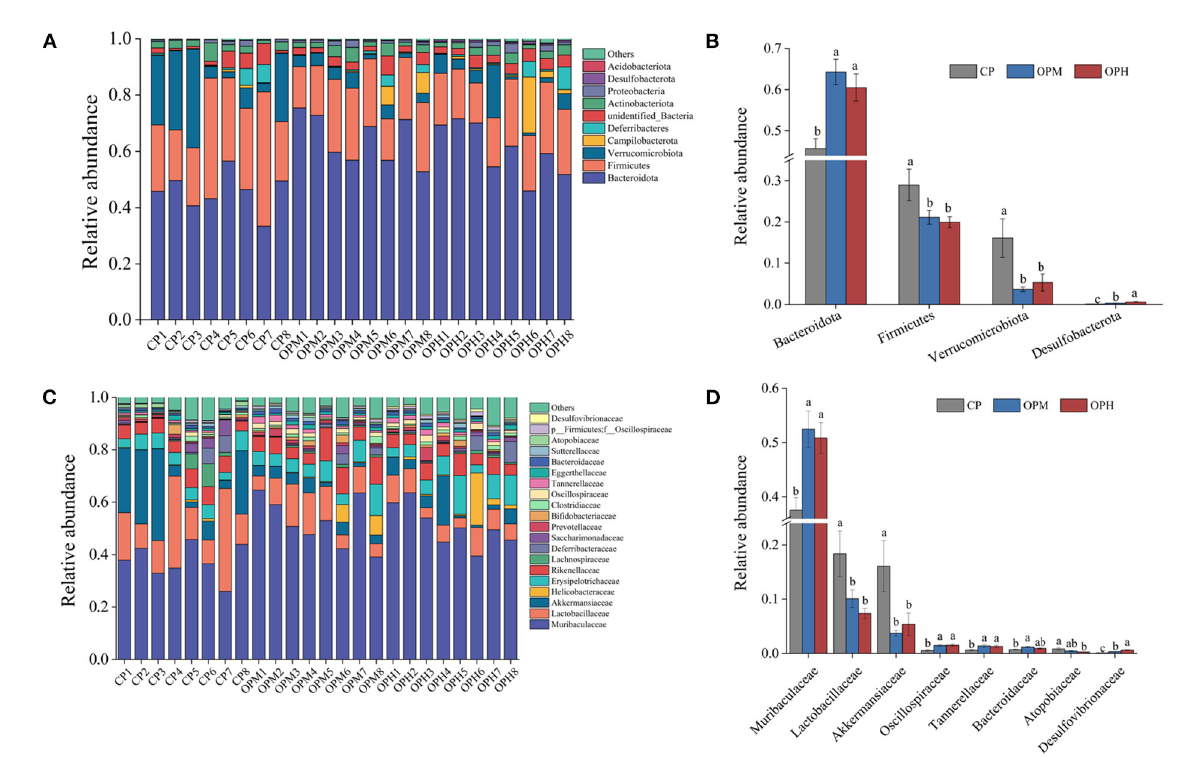
FIGURE3 Effects of consuming oxidized beef protein on GM taxonomic profiles. GM composition at phylum level (A) , relative abundance at phylum level (B) , GM composition at family level (C) , relative abundance at family level (D) . Different letters (a-c) represent significant differences ( p < 0.05). The results were expressed in means ± SEM ( n =